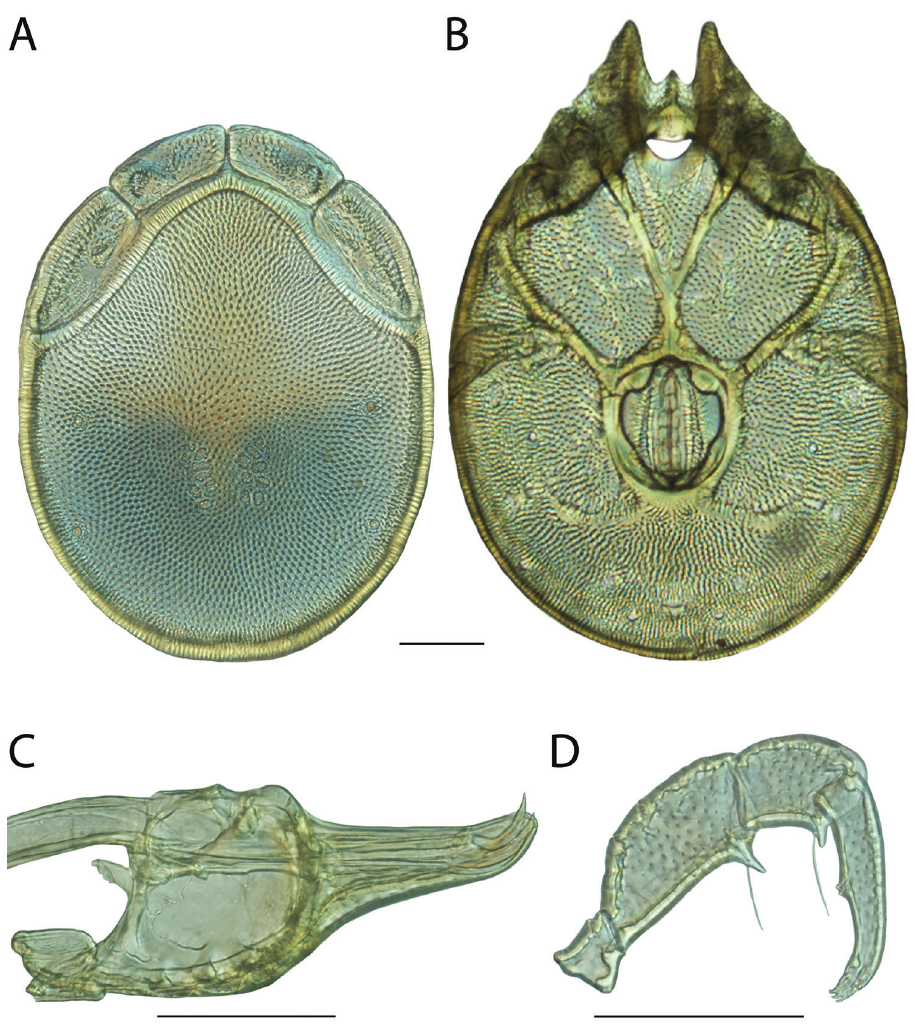
Figure 216. Torrenticola raptoroides sp. n. male: A dorsal plates B venter (legs removed) C subcapitulum D pedipalp (setae not accurately depicted). Scale = 100